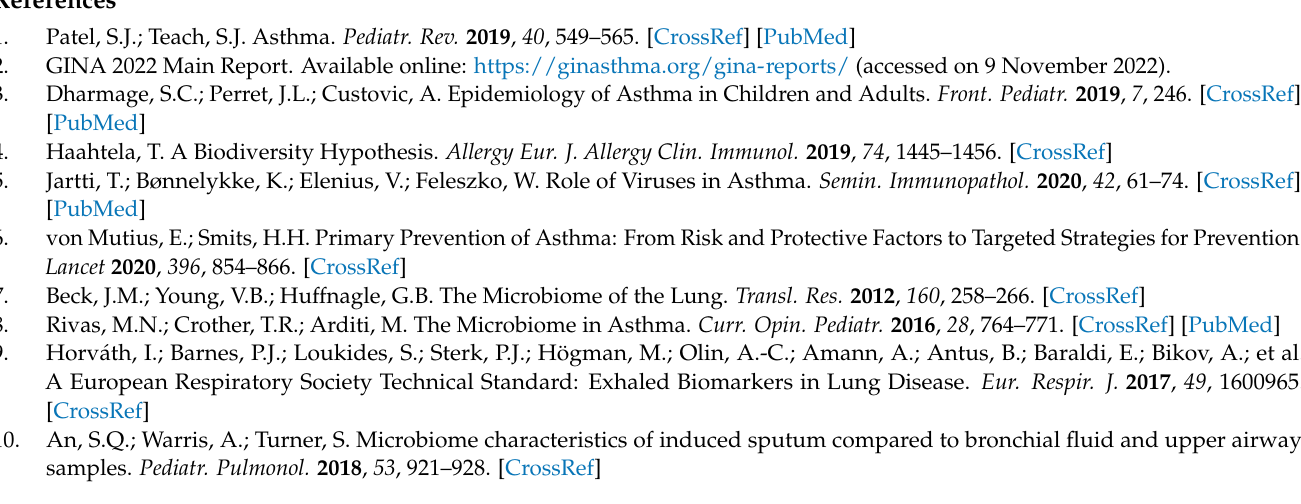
of asthmatic patients. Figure S2. Alpha-diversity metrics for sample type of healthy controls (HC). Figure S3. Alpha-diversity metrics for EBCs of asthmatics with family burden ( n = 14) vs. without family burden of allergic diseases ( n = 4). Figure S4. Alpha-diversity, Pielou’s evenness, asthmatic patients with concurrent inhalant allergies ( n = 17) vs. asthmatic patients without allergies ( n = 2), 0.734 ( ± 0.056) vs. 0.821 ( ± 0.006), p = 0.034, Kruskal-Wallis test. Figure S5. Alpha-diversity